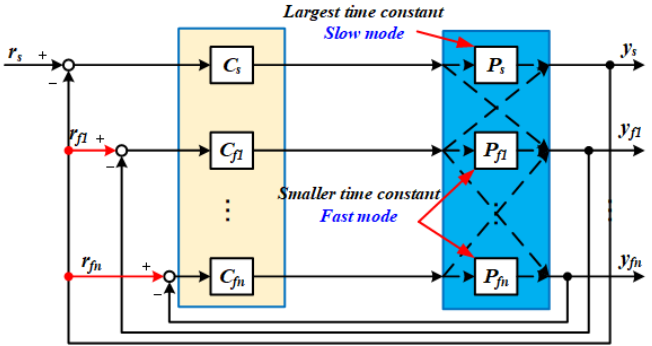
Figure 1. Block diagram of slow-mode-based control (SMBC) control system.